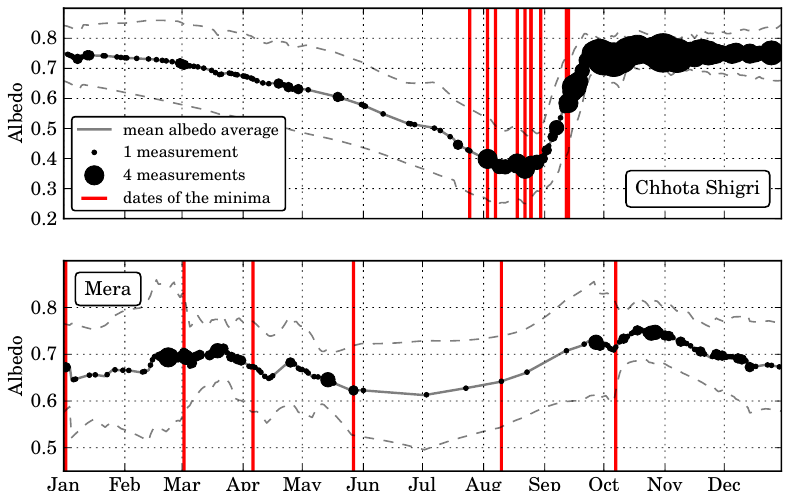
Figure 8. Seasonal variations of the mean albedo for Chhota Shigri (top) and Mera with mask 2 (bottom) glaciers. The solid grey line represents the average of the interpolated daily mean albedo with a 1- σ envelope (dashed grey lines). Note that the scaling of albedo is different on both panels. The size of dots is proportional to the number of good quality images available for the Julian day. The vertical red bars indicate the dates of annual minima for each year under